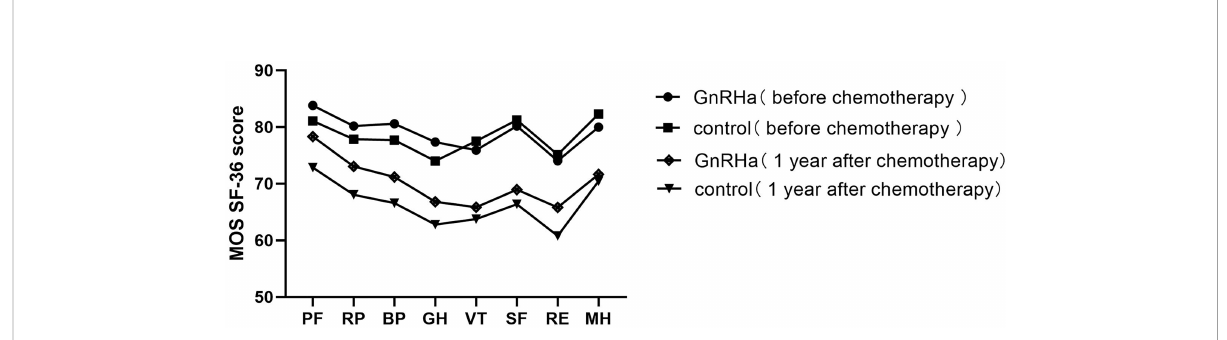
FIGURE 3 Mean MOS SF-36 subscale scores of the GnRHa and control groups before chemotherapy and one year after chemotherapy. MOS SF-36, Medical Outcomes Study Short Form-36; GnRHa, gonadotropin-releasing hormone agonist; PF, physical functioning; RP, role-physical; BP, bodily pain; GH, general health; VT, vitality; SF, social functioning; RE, role-emotional; MH, mental